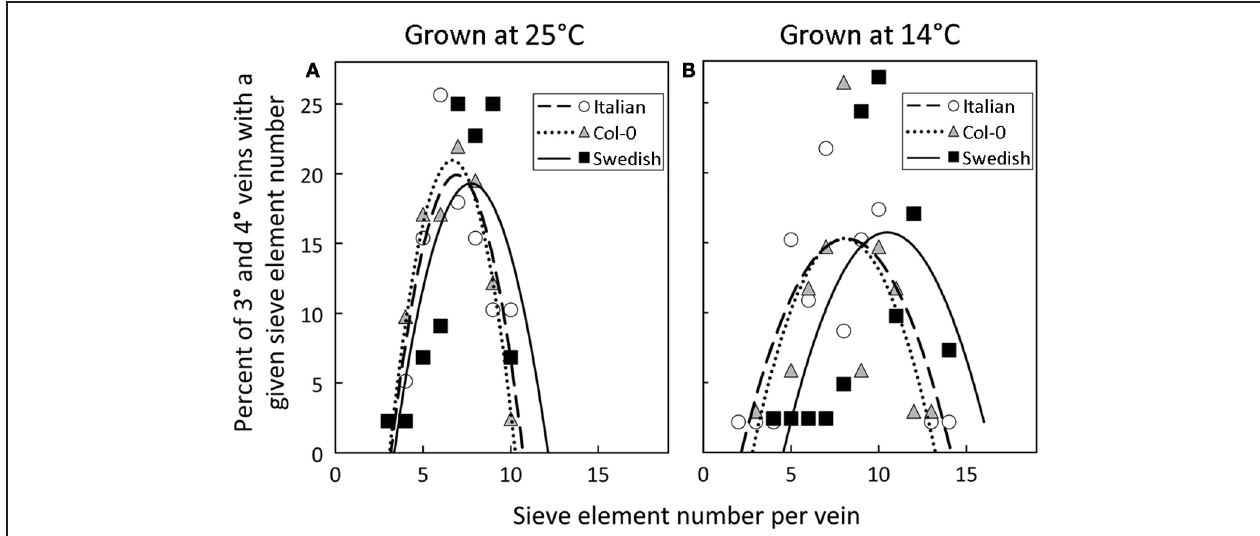
FIGURE 8 | Percent of third- and fourth-order veins ( y -axis) with a given sieve element number per minor loading vein ( x -axis) for Italian (open circles), Col-0 (gray triangles), and Swedish (black squares) A. thaliana